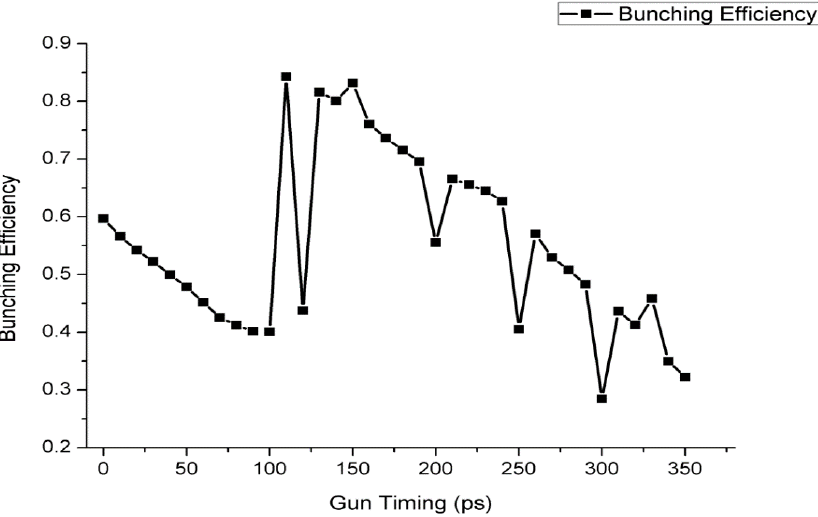
Figure 11. Variations in the bunching efficiency as a function of the gun timing. Table 1. Comparison of the beam parameters obtained at both maximum and minimum at the A0 exit.